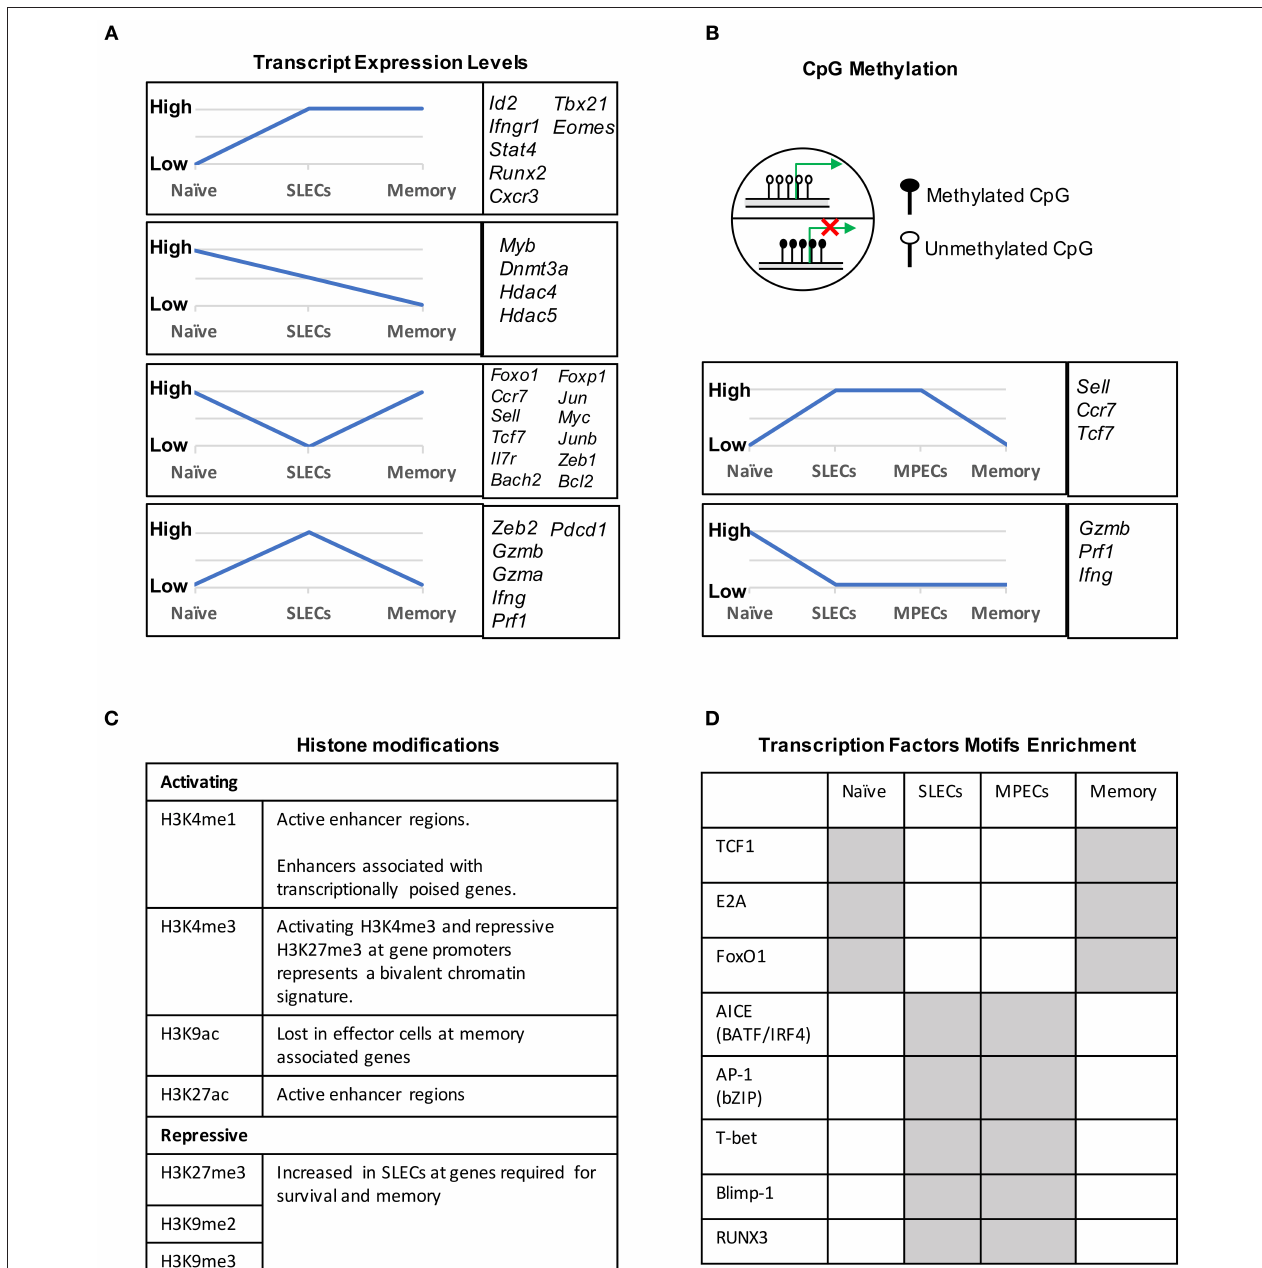
FIGURE 2 | Transcriptional and epigenetic profiling during naïve to effector to memory transition. (A) Gene clusters defined by the mRNA expression levels in naïve, SLECs and memory cells. Four major expression patterns emerged: genes that were up- or downregulated during the effector stage and persisted into the memory phase, and genes that were up- or downregulated during the effector phase and then reverted to the naive state. (B) CpG methylation levels of different genes in naïve, SLECs, MPECs and memory cells. Naïve/memory genes are similarly acquired CpG methylation in both SLECs and MPECs. MPECs, not SLECs, have the capacity to erase their newly acquired methylation programs and re-express naïve/memory genes as they develop into memory CD8T cells. SLECs and MPECs both show demethylation of several effector-associated genes which remain demethylated in memory cells for a long period of time. (C) Histones posttranslational modification (PTM) and their functions that are essential for CD8T cell differentiation. For example, the epigenetic bivalency for H3K27me3 and H3K4me3 represent an epigenetic state from which a gene can be rapidly activated or repressed depending on the differentiation pathways. (D) Differentially enriched motifs of transcription factors in naïve, effector and memory cells. Motif analysis identified the cell-subsets specific transcription factors binding sites in enhancer or promoter regions. Gray depicts highly enriched motifs.